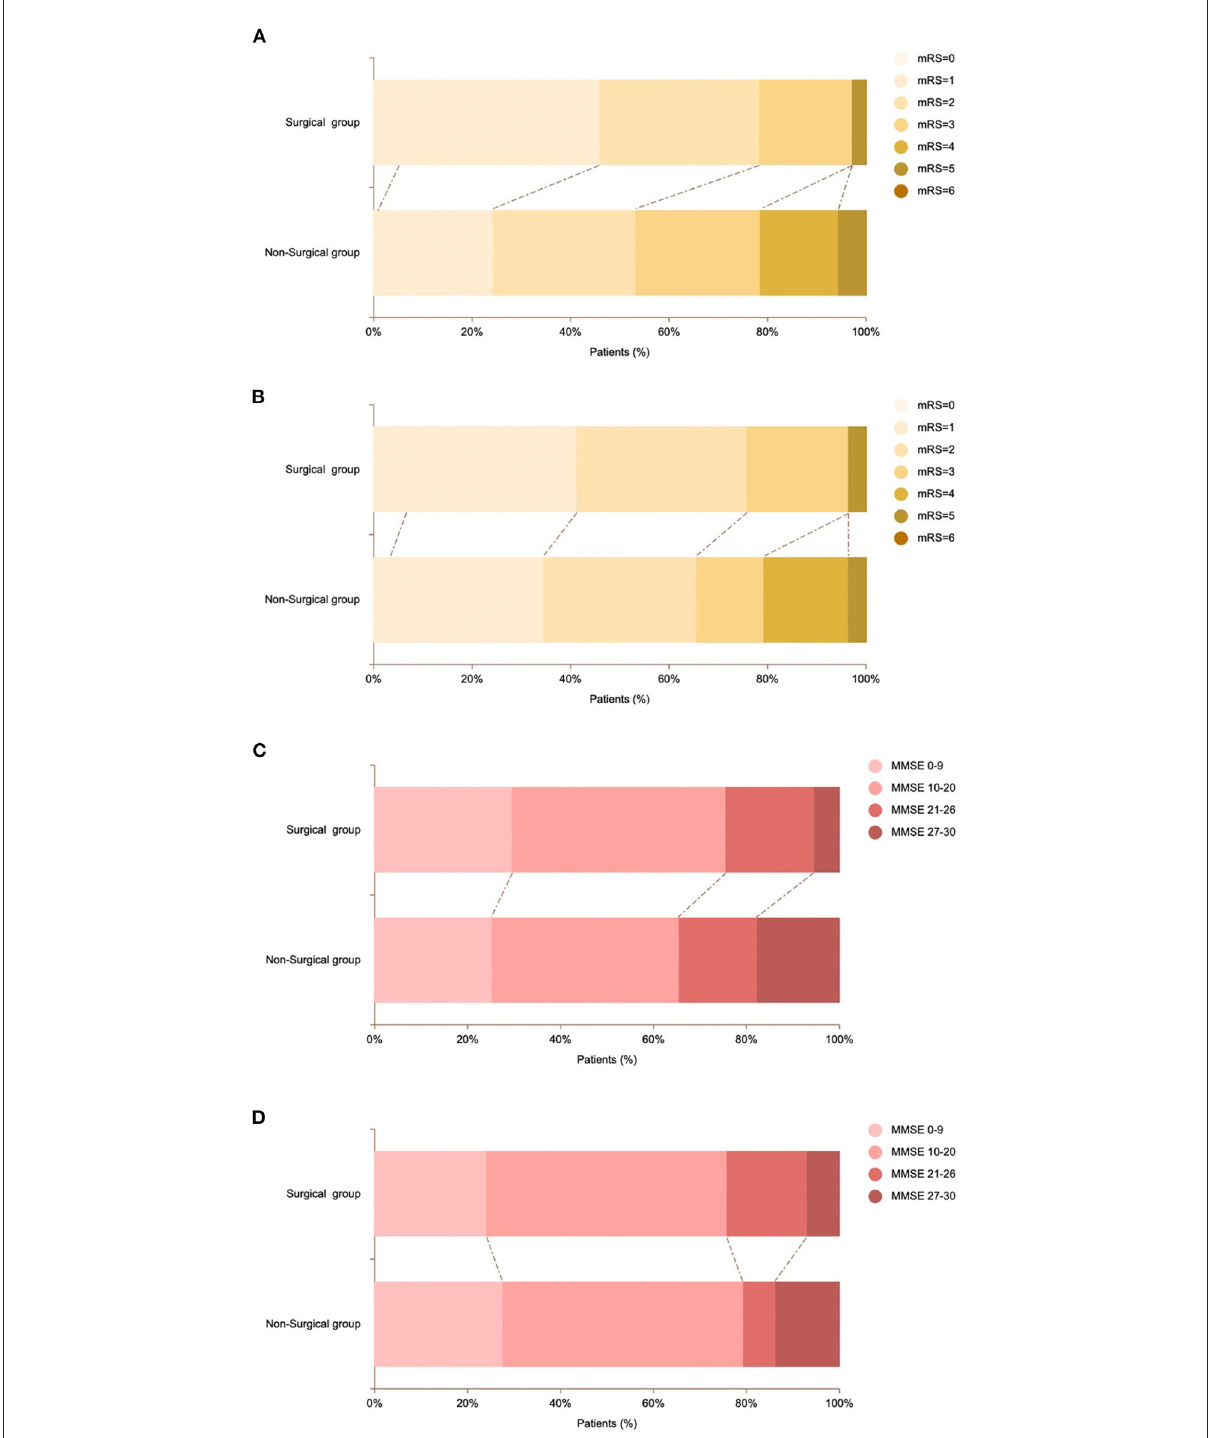
FIGURE4 Comparison of mRS scores and MMSE scores of patients in surgical and non-surgical group. (A) Proportion of mRS scores ranging from 0 (light yellow) to 6 (brown) at admission for patients in the surgical and non-surgical groups. (B) Proportion of mRS scores at admission for surgical and non-surgical patients in propensity score-matched groups. (C) Proportion of MMSE scores ranging from 0 (pink) to 6 (dark red) at admission for patients in the surgical and non-surgical groups. (D) Proportion of MMSE scores at admission for surgical and non-surgical patients in propensity score-matched